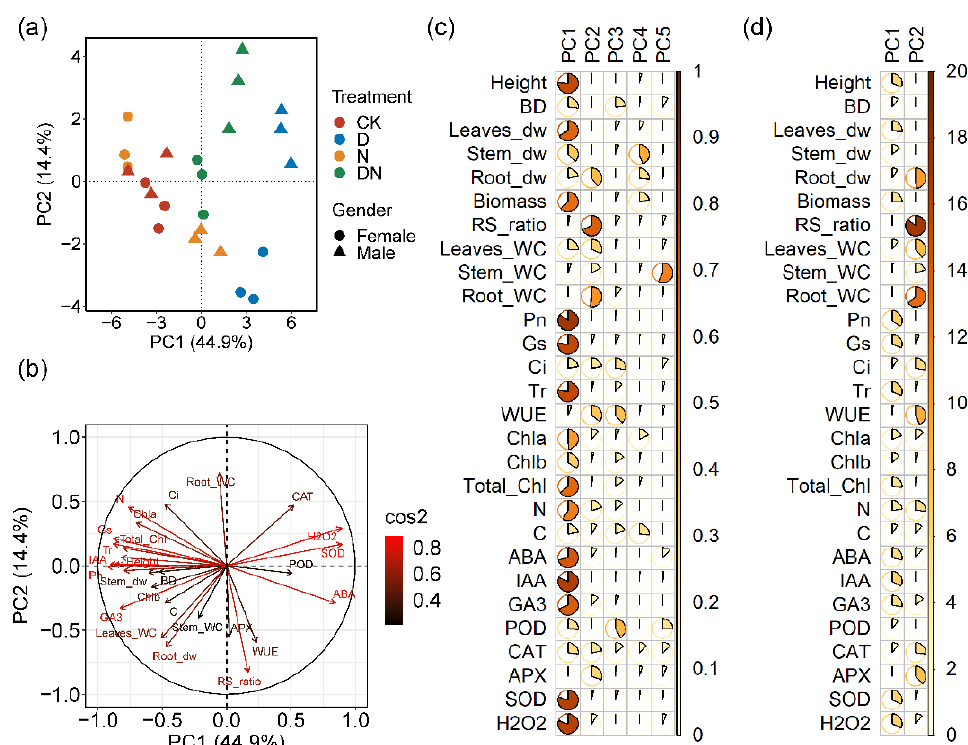
Figure 1. The phenotypic parameters of S. myrtillacea cuttings. ( a ) Morphology of cuttings after treatments. The black line denotes 10 cm length; ( b ) the height of cuttings ( n = 6); ( c ) the base diameter of cuttings ( n = 6). F, females; M, males; C, control; N, N deposition; D, drought; DN, drought and N deposition. The double dagger (‡) indicates simple e ff ect of gender, the dagger (†) indicates simple effect of drought, and the inverted dagger ( ⸸ ) indicates simple effect of N deposition. Different letters indicate significant differences (Tukey test, p < 0.05). The black dot indicates outlier. Asterisks denote significant differences: ***, p < 0.001; **, p < 0.01.